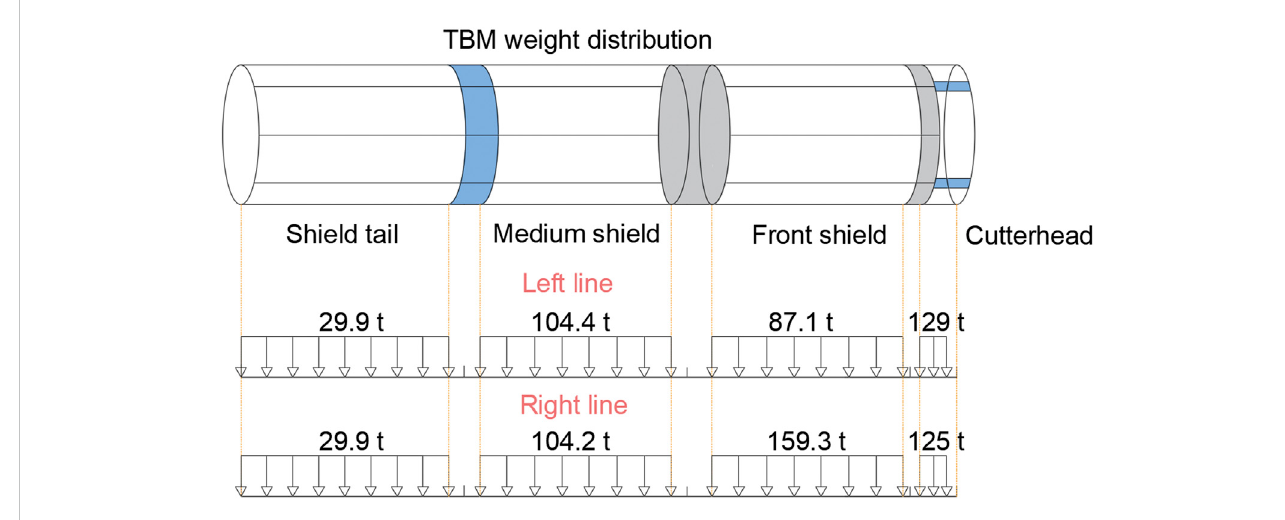
FIGURE 7 TBM tunnel weight